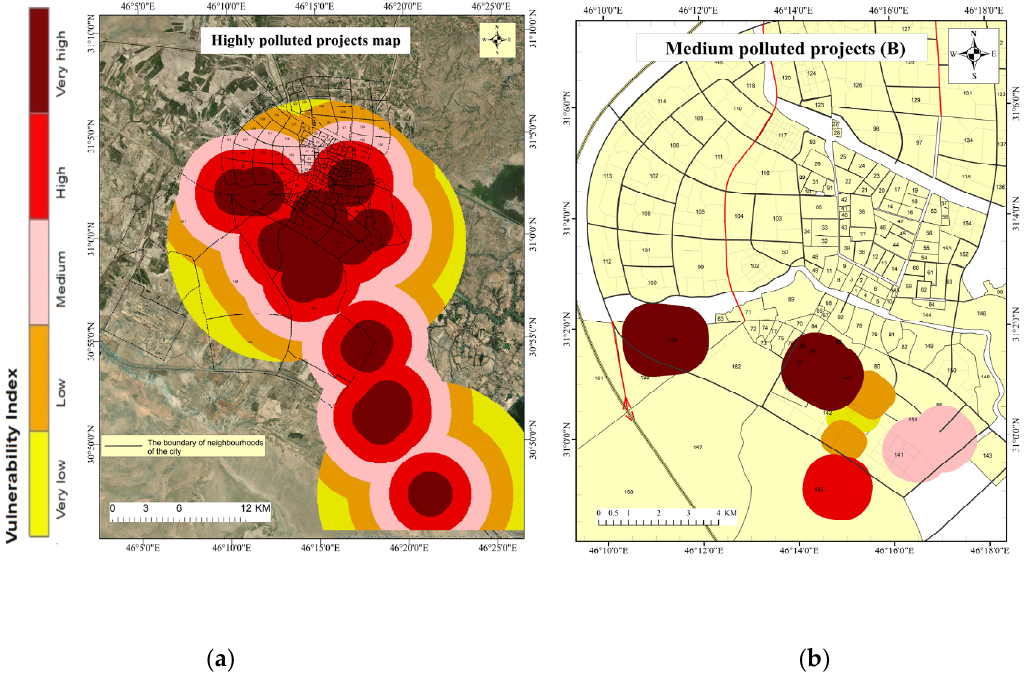
Figure 18. Sub-criteria of the environmental domain: ( a ) map of the high sources of pollution (C1) and ( b ) map of the moderate sources of pollution (C2).